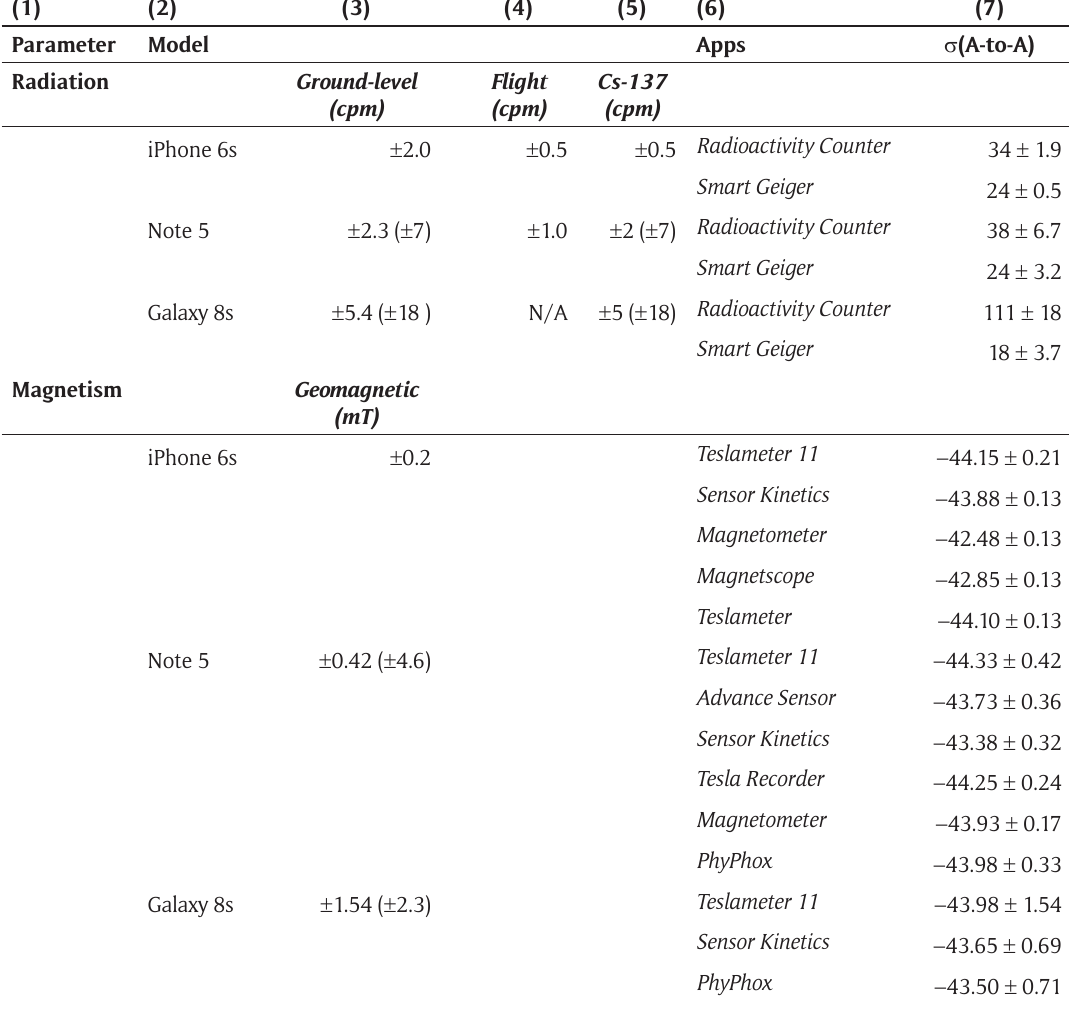
Table 10: Comparison of smartphone measurement